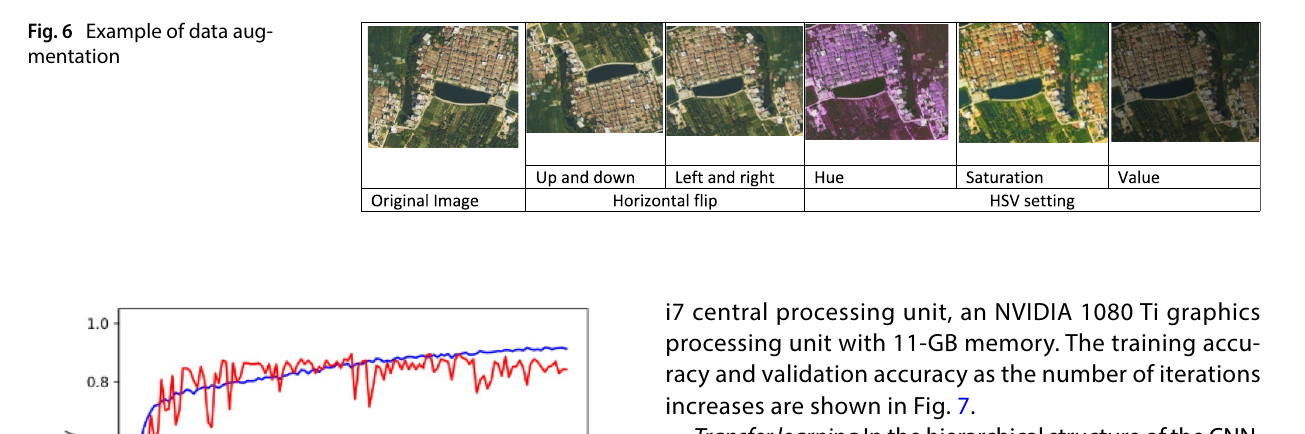
Fig. 5 Schematic diagram of image classification pipeline and the GAP structure. Note a The input picture size is 280 × 224. b After the first five convolution modules, the feature map with 512 channels is